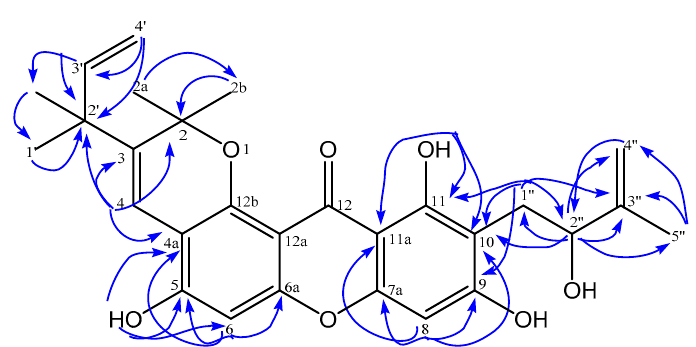
Figure 2. Selected HMBC correlation for 5,9,11-trihydroxy-10-(2 ″ -hydroxy-3 ″ -methylbut-3 ″ -en-1-yl)- 2,2-dimethyl-3-(2 ′ -methylbut-3 ′ -en-2 ′ -yl)-2H,12H - pyrano[2,3-a]xathen-12-one.